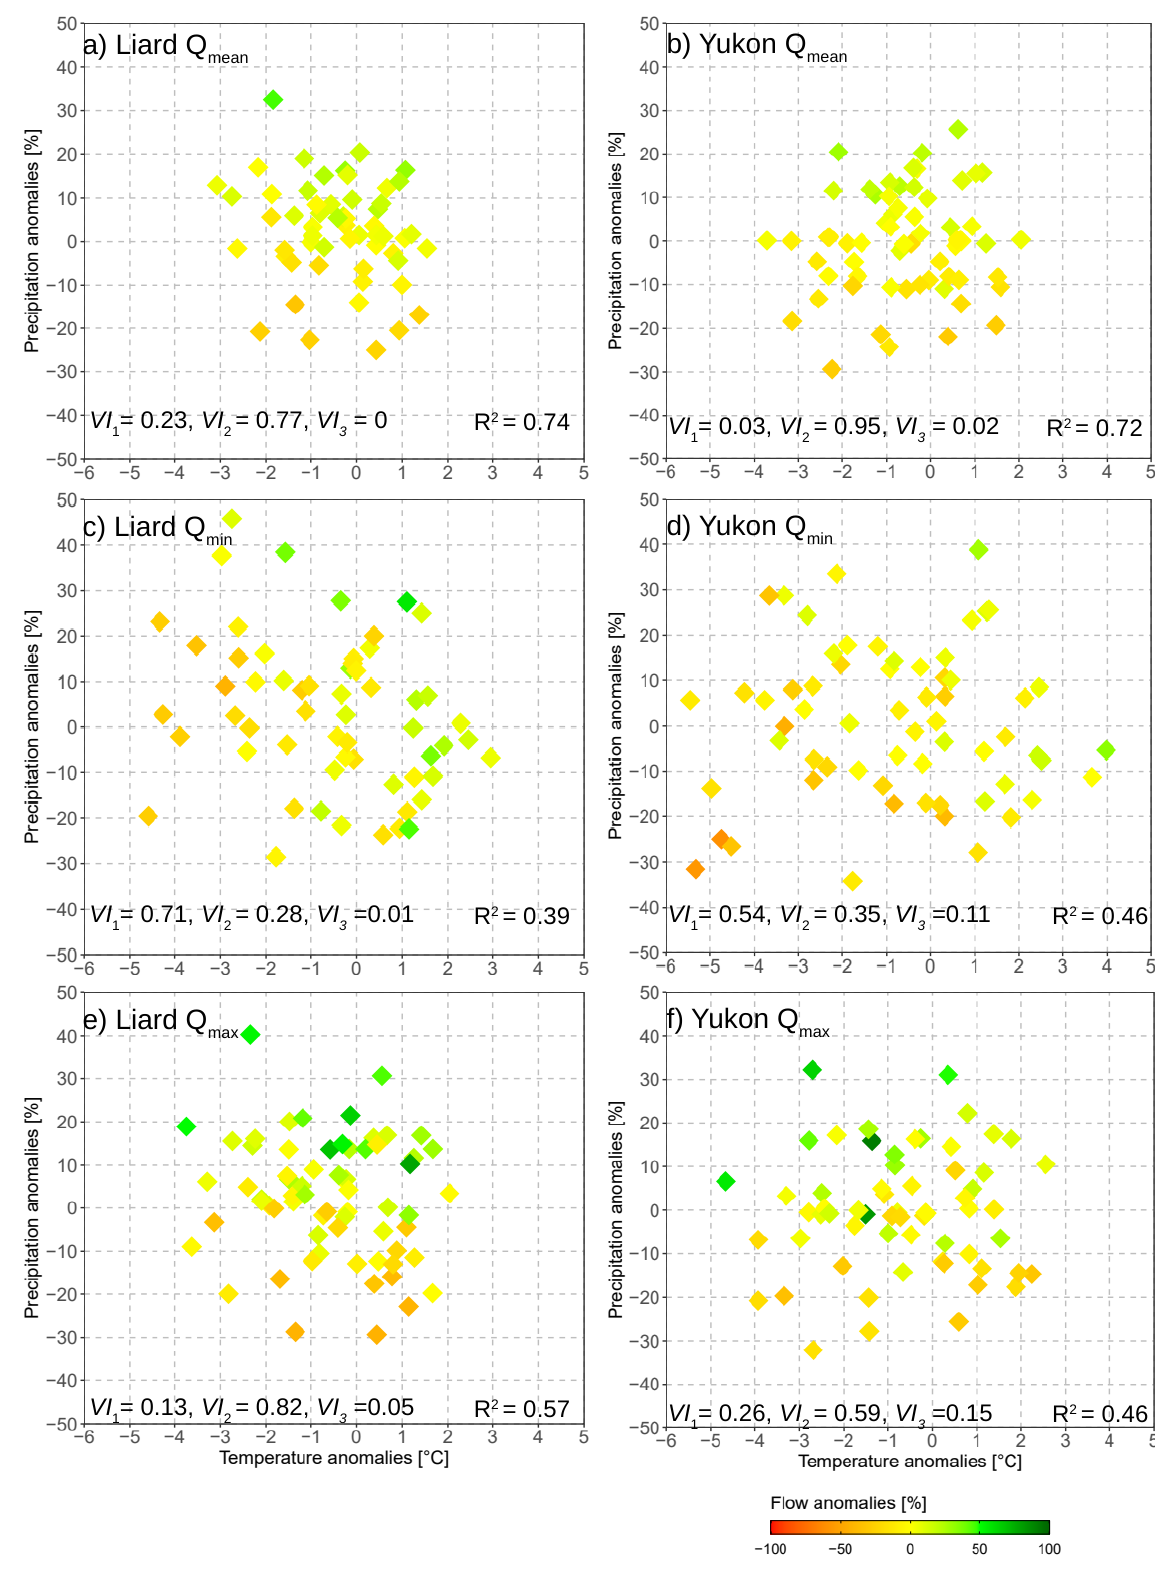
Figure 4. Sensitivity plots of streamflow anomalies against annual/seasonal temperature ( ◦ C) and precipitation (%) anomalies with respect to 1976–2005 period. Illustrated results for Liard and Yukon Rivers include: ( a , b ) Q mean against Ann_T and Ann_P; ( c , d ) Q min against October to March temperature (O–M_T) and precipitation (O–M_P); and ( e , f ) Q max against October–June temperature (O–J_T) and precipitation (O–J_P)